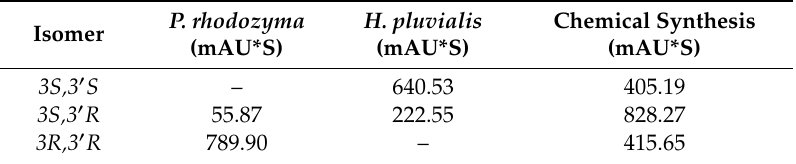
Table 1. Peak area of the individual enantiomers of astaxanthin sourced from P. rhodozyma , H. pluvialis , and chemical